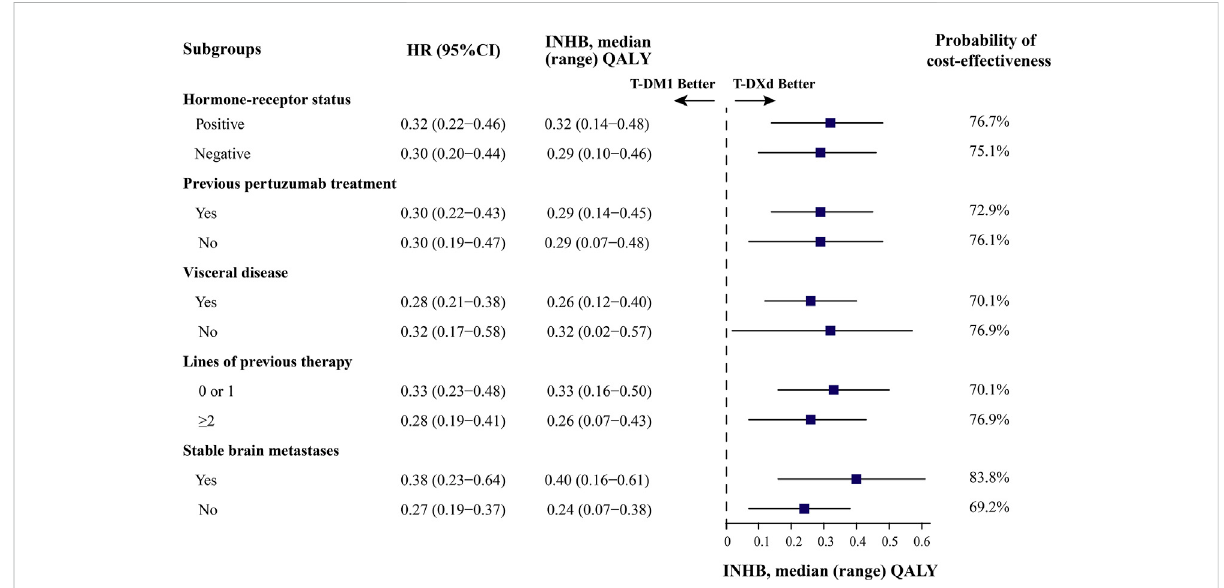
FIGURE 4 Subgroup analysis results of INHBs and probabilities of being cost-effective for progression-free survival in the US. The vertical dotted line represents the point of no effect (INHB = 0), the dark blue squares represent the median INHBs, and the horizontal lines represent the ranges of INHBs adjusted by the HRs. HR, hazard ratio; INHB, incremental net-health bene fi t; PFS, progression-free